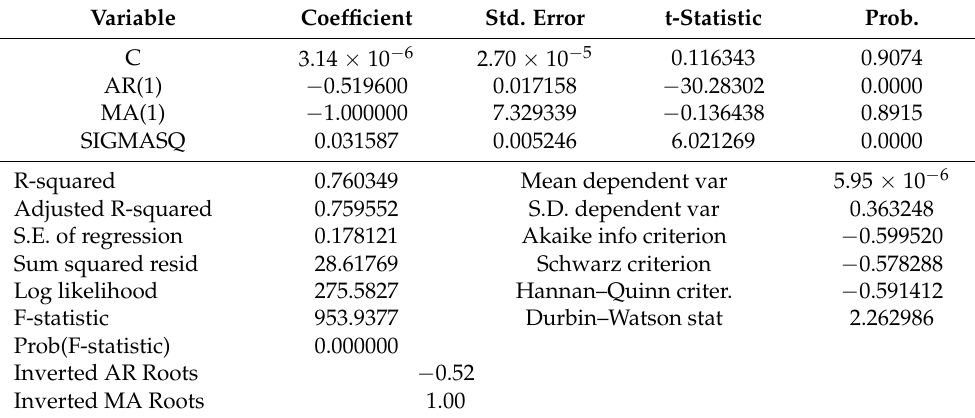
Table 3. ARMA Model of Average Returns in FINTECH market of